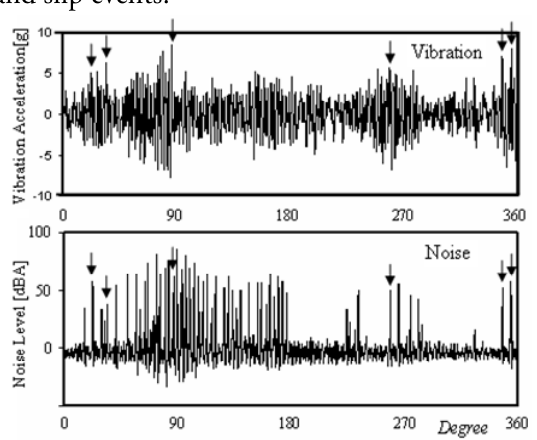
Fig. 7. Measured vertical vibration of the disk and the induced noise (Steel pin, normal load 40[N], Vpin= 5.2